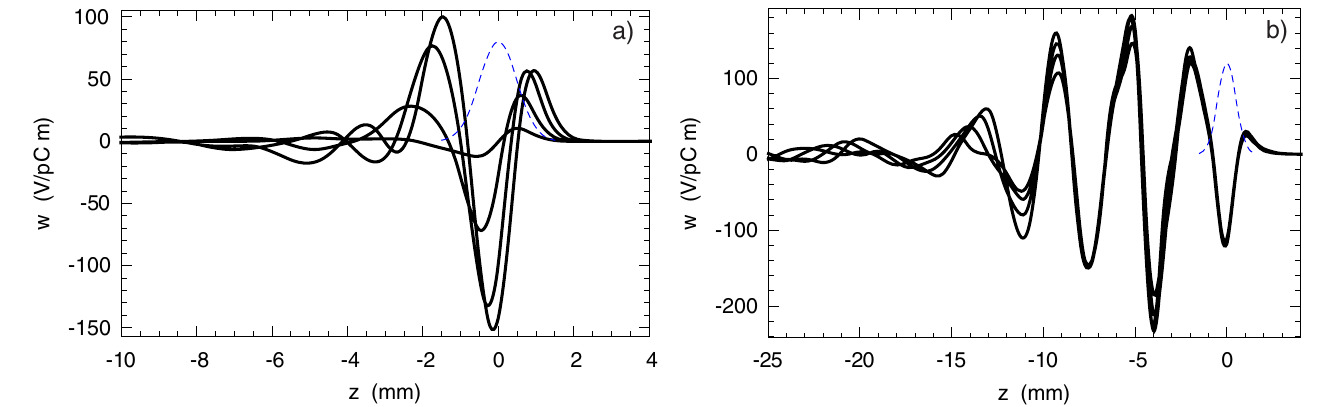
FIG. 7. (Color) Wakefields for the case A ¼ 1 and b ¼ 2 cm at various distances from the entrance to the toroid: (a) distances 4, 8, 12, and 16 cm from the entrance (a larger distance corresponds to a larger amplitude of the wake), (b) distances 84, 88, 92, and 96 cm from the entrance.